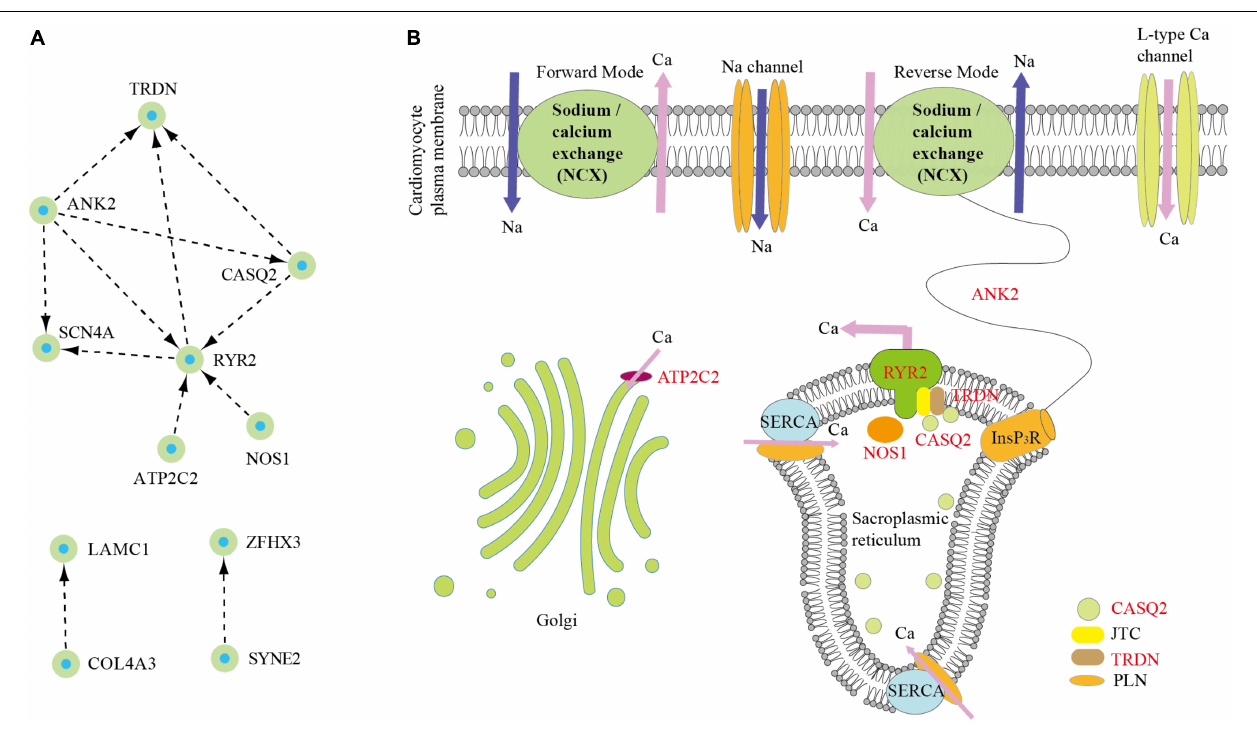
FIGURE 4 | Identification of core-signaling pathway in atrioventricular nodal reentrant tachycardia (AVNRT). (A) The protein–protein interactions analysis of 14 pathogenic genes. (B) Schematic representation of core-signaling pathway in AVNRT.